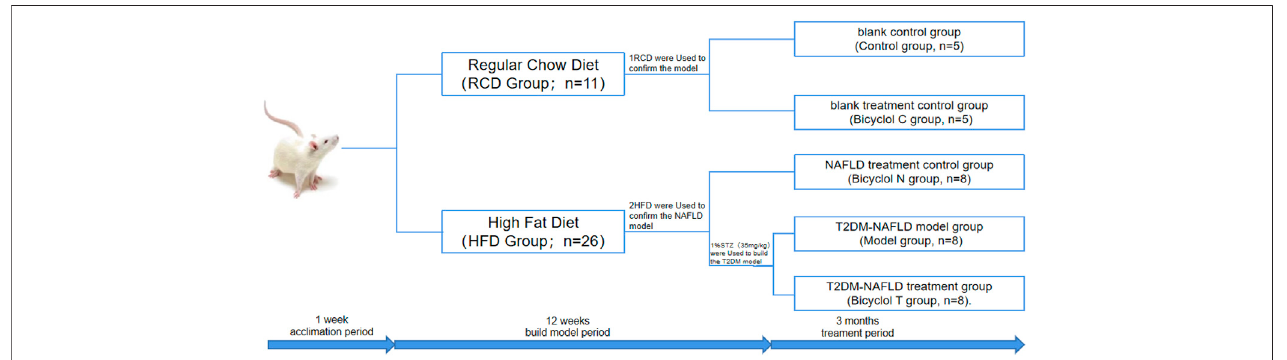
FIGURE 1 | Schematic diagram of experiment